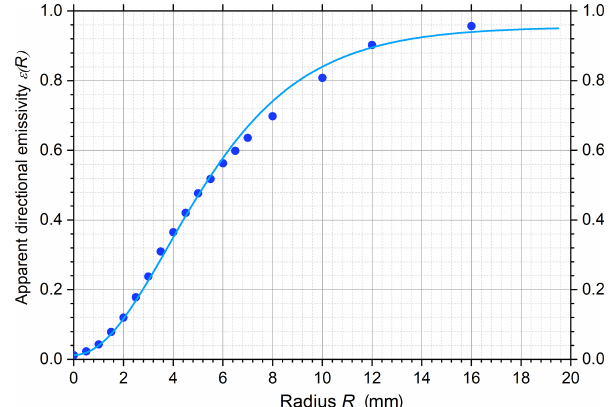
Figure 6. Apparent directional emissivity ε ( R ) measured with the TIR 100-2 for different-sized apertures corresponding to a deter- mination of the measurement field of the instrument. The measured data are compared with a model for the measurement field size func- tion f ( R ) integrated over the respective aperture sizes according to Eq.